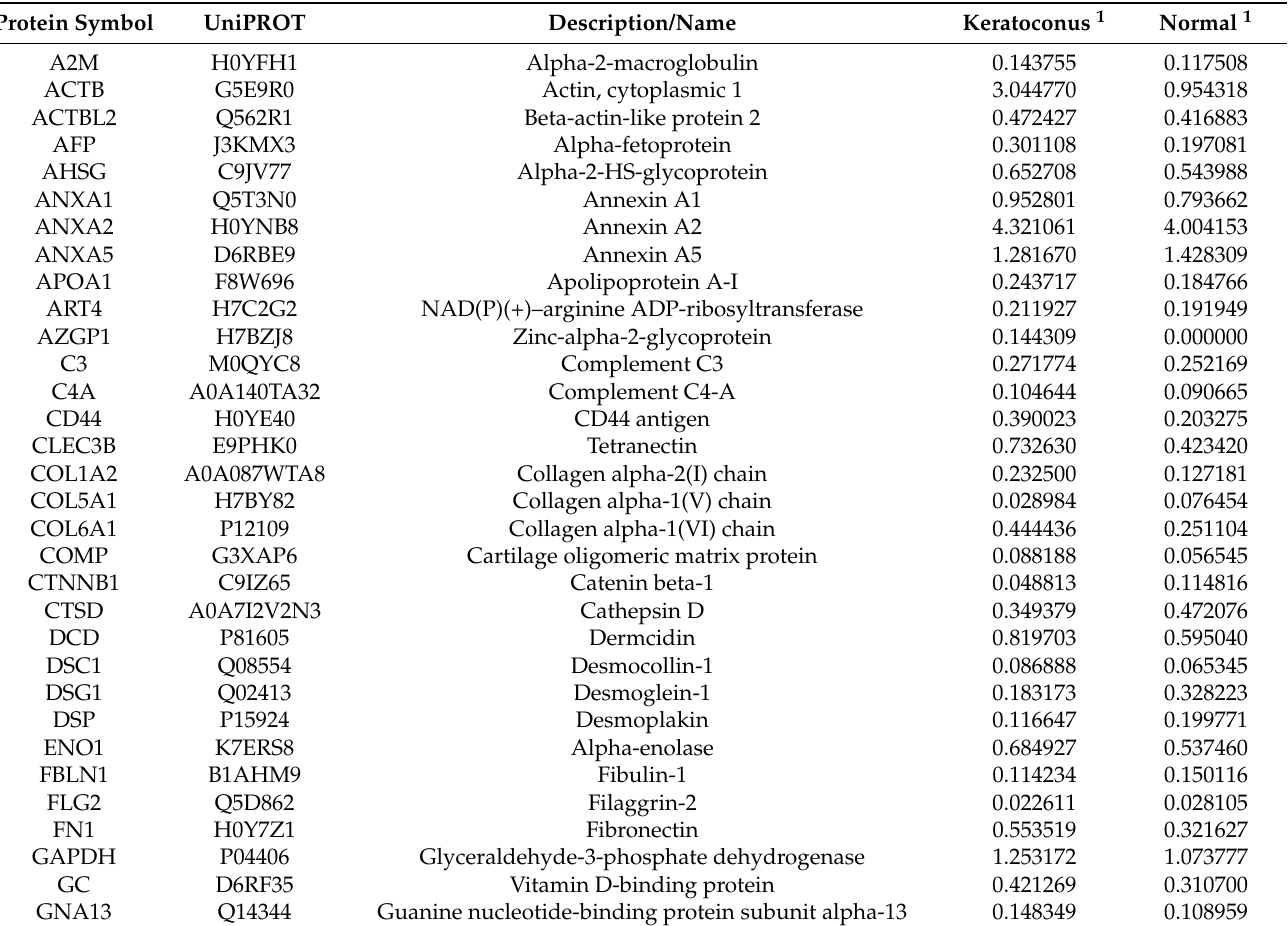
Table 1. Proteins detectable in all exosome samples isolated from either healthy stromal cells or those from patients with